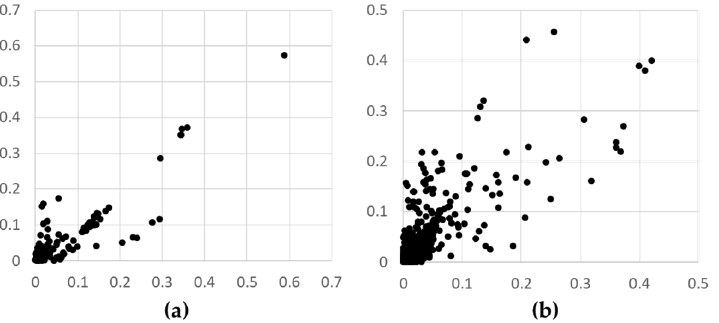
Figure 7. The variance of forecasting errors of the case of forecasting P based on the forecasting error of the case of forecasting P kdemax , where ( a ) represents the result of the dates between 12.01 and 12.07, and ( b ) between 12.08 and 12.31.